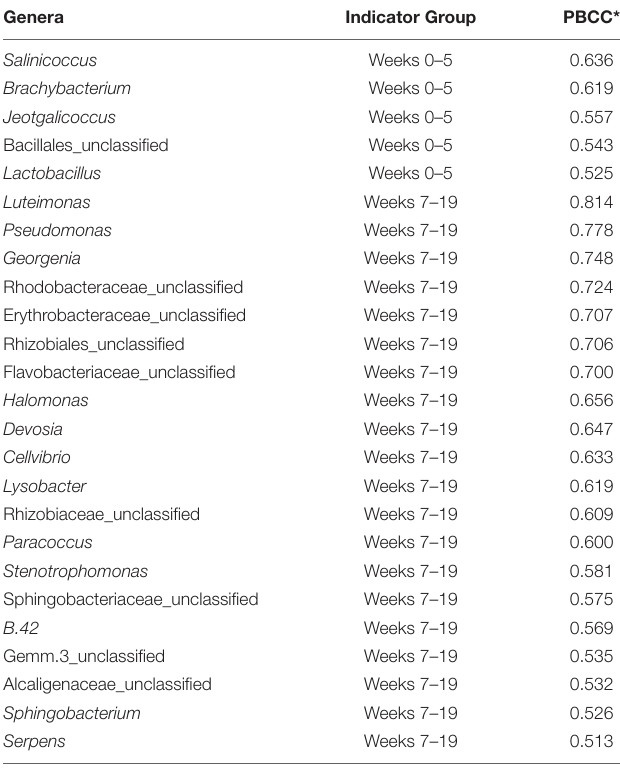
TABLE 4 | Indicator species for Spent Larvae sampled while piled in